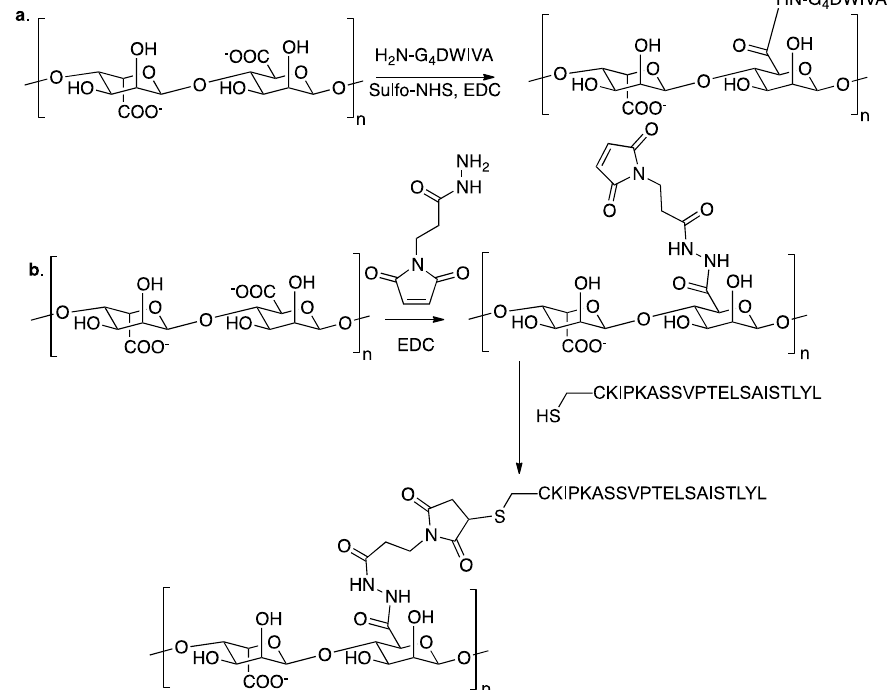
Figure 6. Alginate-based hydrogel designed to promote osteogenesis in murine mesenchymal stem cells. ( a ) Conjugation strategy for the DWIVA peptide; ( b ) Conjugation strategy for the “knuckle epitope”.